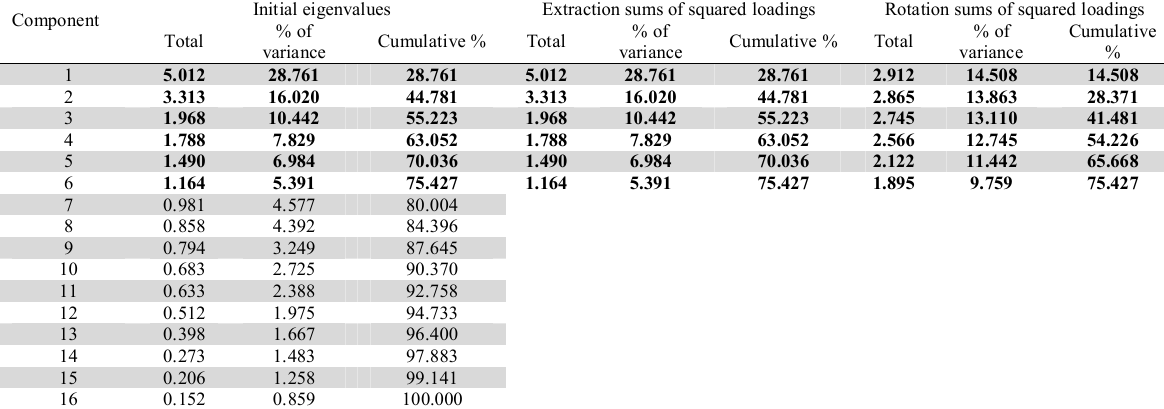
Final statistics in rotated component matrix using Varimax rotation method were present in Table 3. Small quadrangles in Table 3 explain six final components (or factors) based on their factor